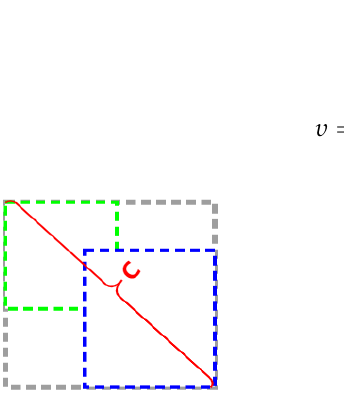
Figure 8. The diagonal distance of the smallest box (gray rectangle), which covers the predicted bounding box (green rectangle) and ground truth (blue rectangle).